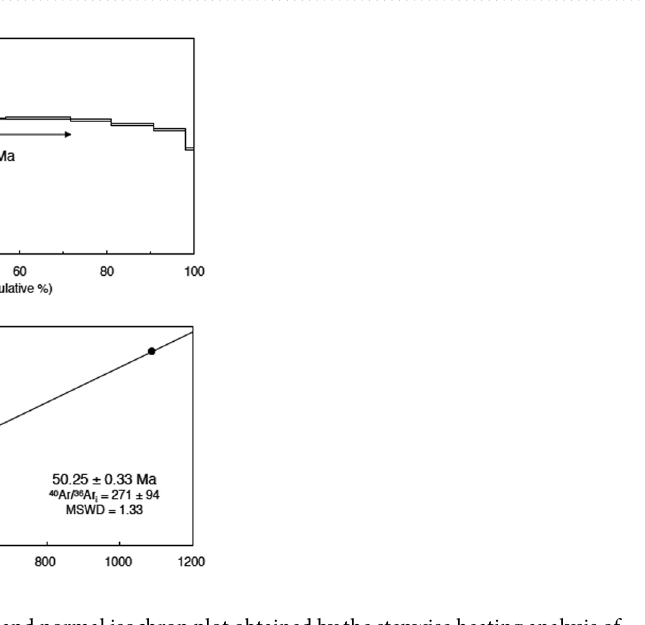
Figure 2. 40 Ar/ 39 Ar age spectrum and normal isochron plot obtained by the stepwise heating analysis of groundmass sample, P2-Lrl. C17004: Laboratory-ID. The error in the age spectrum shows 1 sigma error. Closed circles in the isochron plot are derived from plateau steps while open circles are not. Plateau age and isochron age from the plateau steps correspond